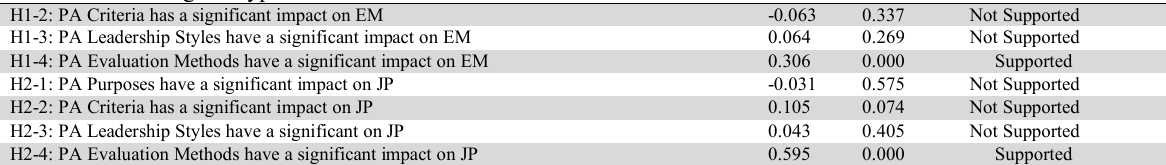
The results of testing the hypotheses H1-2: PA Criteria has a significant impact on